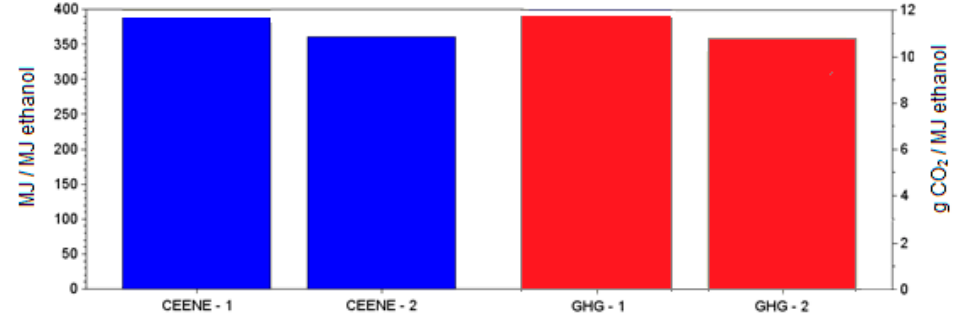
Figure 5. Greenhouse gases (GHG) and exergy alterations for both scenarios.